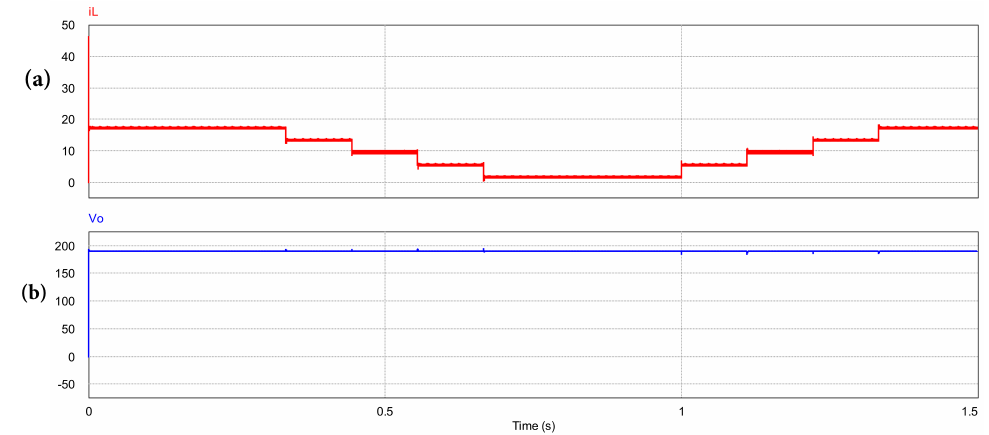
Figure 19. DC-DC full bridge converter 3.3 kW at 190 V with state feedback controller. ( a ) inductor current, ( b ) output voltage.